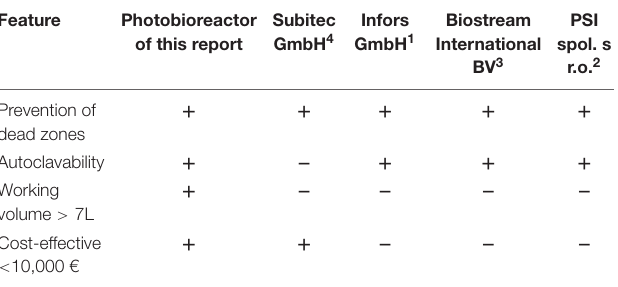
TABLE 2 | Comparison of the photobioreactor presented in this brief report with selected commercially available photobioreactors operated as gas-lift reactors in the laboratory